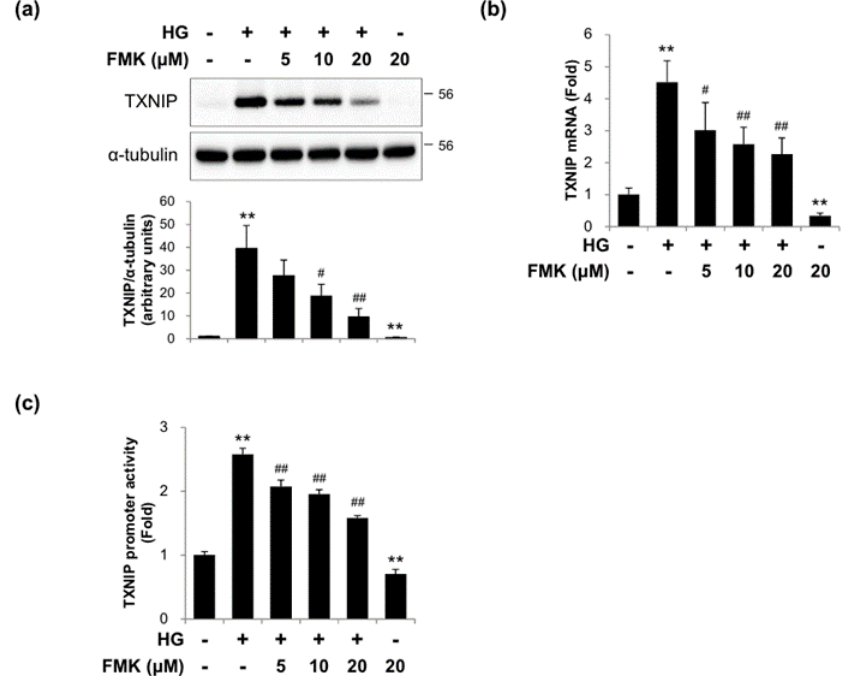
Figure 2. FMK inhibited high glucose-induced TXNIP expression. ( a ) INS-1 cells were pretreated with FMK (5, 10 or 20 μM) for 1 h, and then incubated with high glucose ( HG, 25 mM) for 24 h. Protein levels were measured by immunoblotting using antibodies against TXNIP and α -tubulin. The graph shows the densitometric quantification of western blot bands. Results are expressed as means ± SDs and are representative of three independent experiments. ** p < 0.01 vs. non-treated controls, # p < 0.05 and ## p < 0.01 vs. HG-treated cells. ( b ) INS-1 cells were pretreated with FMK (5, 10 or 20 μM) for 1 h, and then incubated with HG for 24 h. mRNA levels of TXNIP were measured by qRT-PCR. Relative expression levels were normalized versus GAPDH. Results are expressed as the means ± SDs of three independent experiments. ** p < 0.01 vs. non-treated controls, # p < 0.05 and ## p < 0.01 vs. HG-treated controls. ( c ) INS-1 cells were transfected with a TXNIP-luc containing construct driven by full-length TXNIP promoter, and after 24 h of transfection were pretreated with FMK (5, 10 or 20 μM) for 1 h, and then incubated with HG for 24 h. Luciferase activities in cell lysates were determined using a dual luciferase reporter assay kit with a Glomax 20/20 luminometer. Transfection efficiencies were normalized versus Renilla luciferase activity derived from pRL-tk construct. Results are expressed as the means ± SDs of three independent experiments. ** p < 0.01 vs. non-treated controls, ## p < 0.01 vs. HG-treated controls.